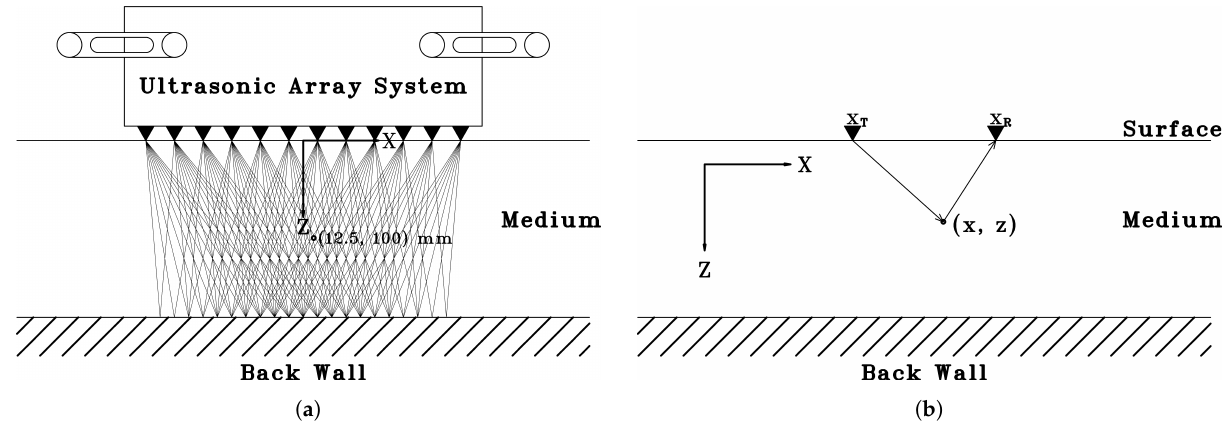
Figure 2. ( a ) Ultrasonic array system and scanning scheme and ( b ) array